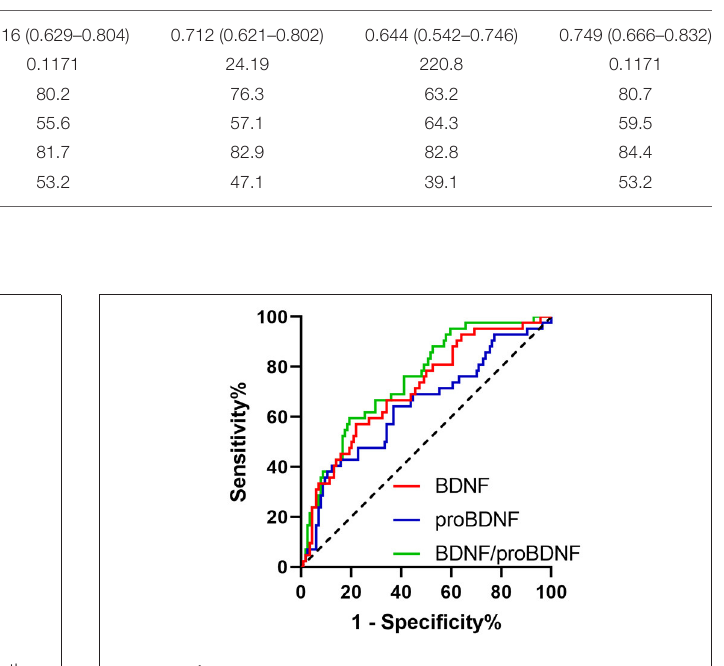
Horizontal Comparison of the Levels of proBDNF, mBDNF, and mBDNF/proBDNF Ratio Between the Two Groups at Initial Visit and Follow-Up